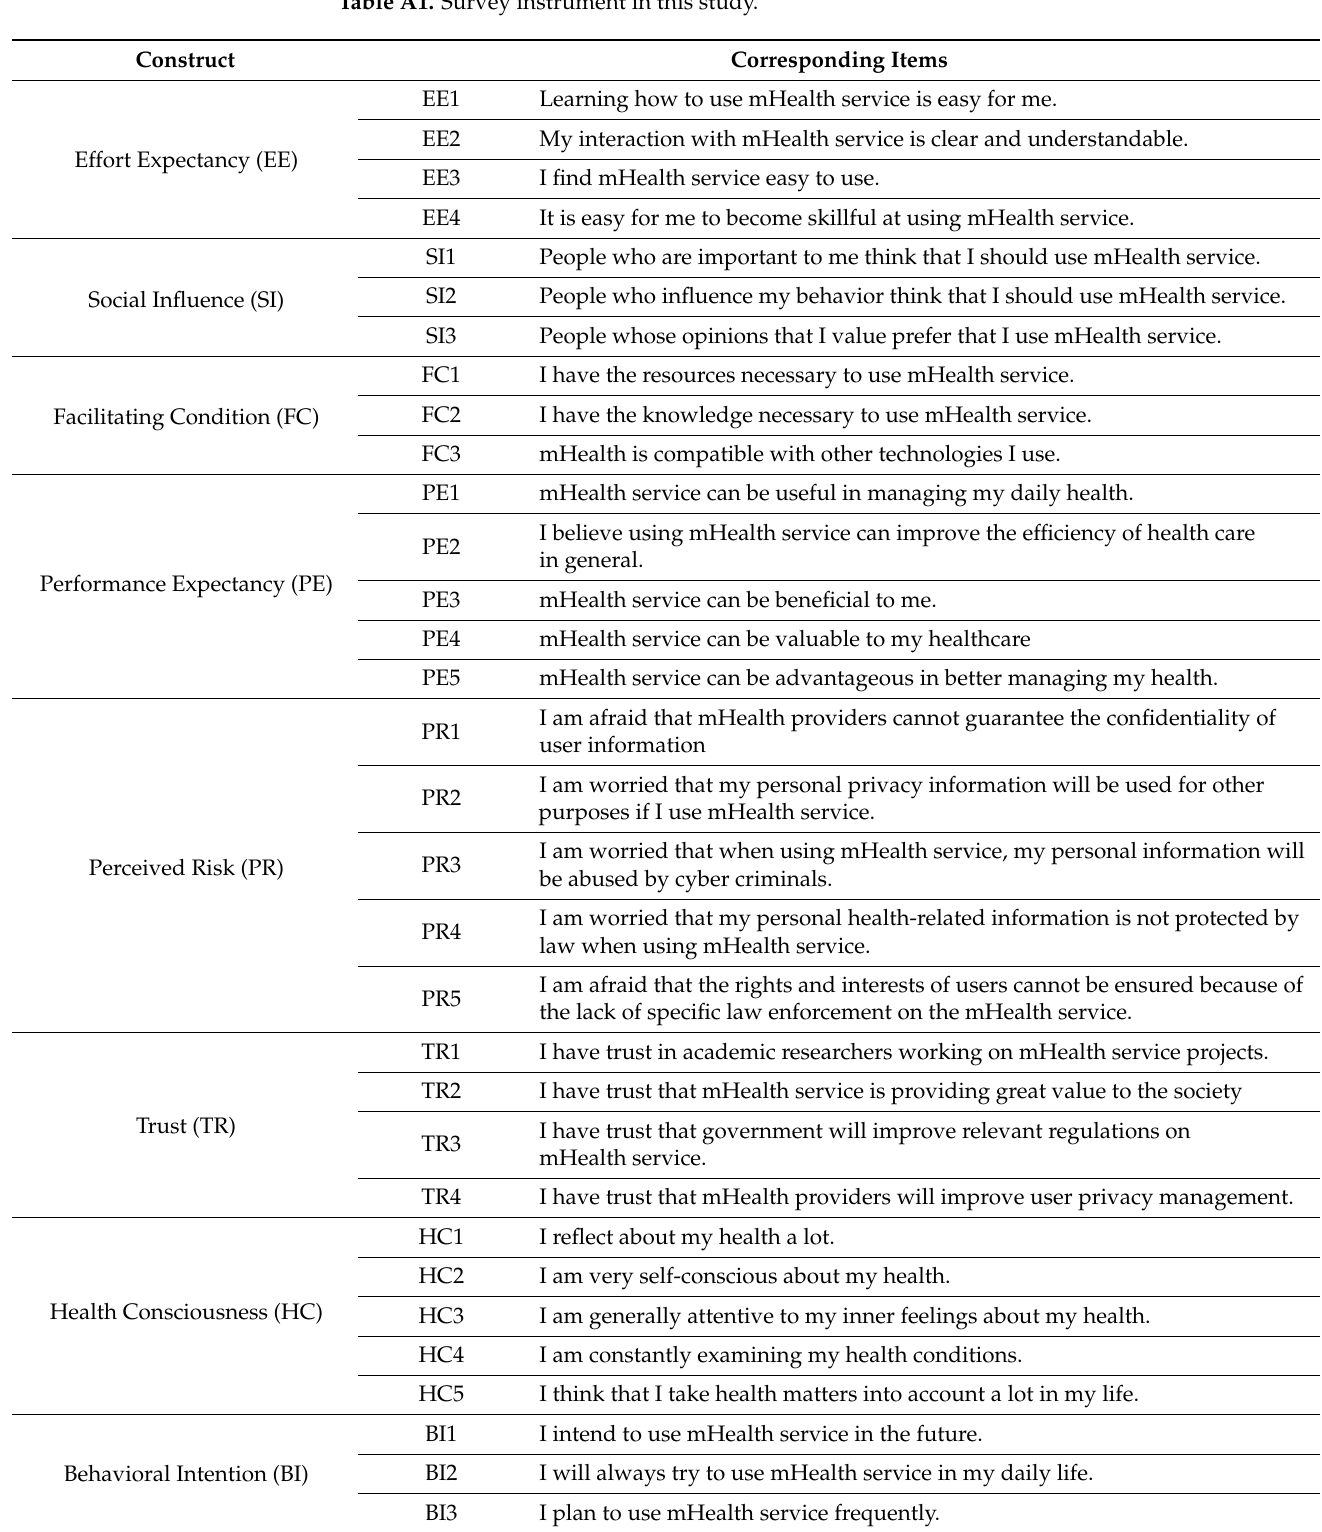
Table A1. Survey instrument in this